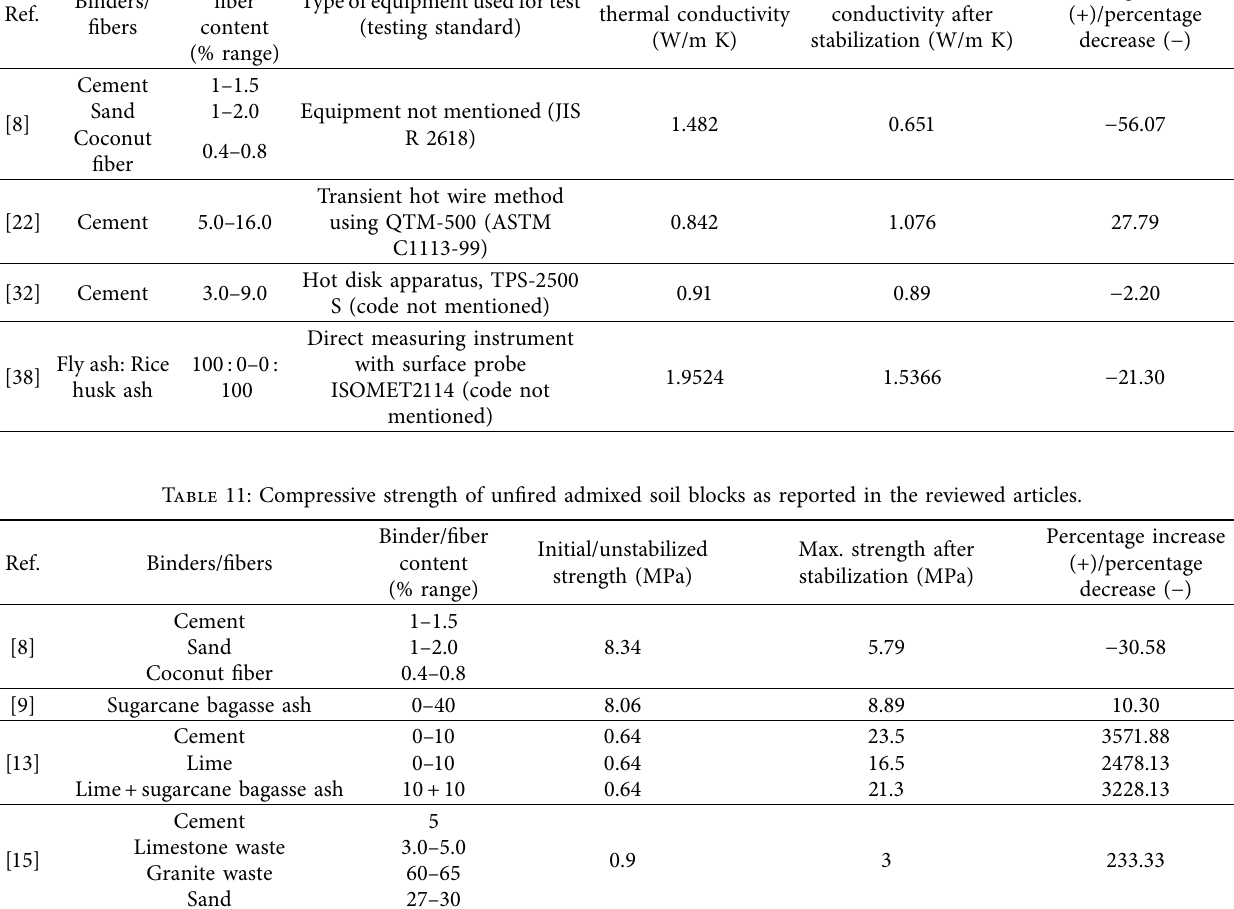
Table 10: Thermal conductivity of unfired admixed soil blocks as reported in the reviewed articles. Ref.